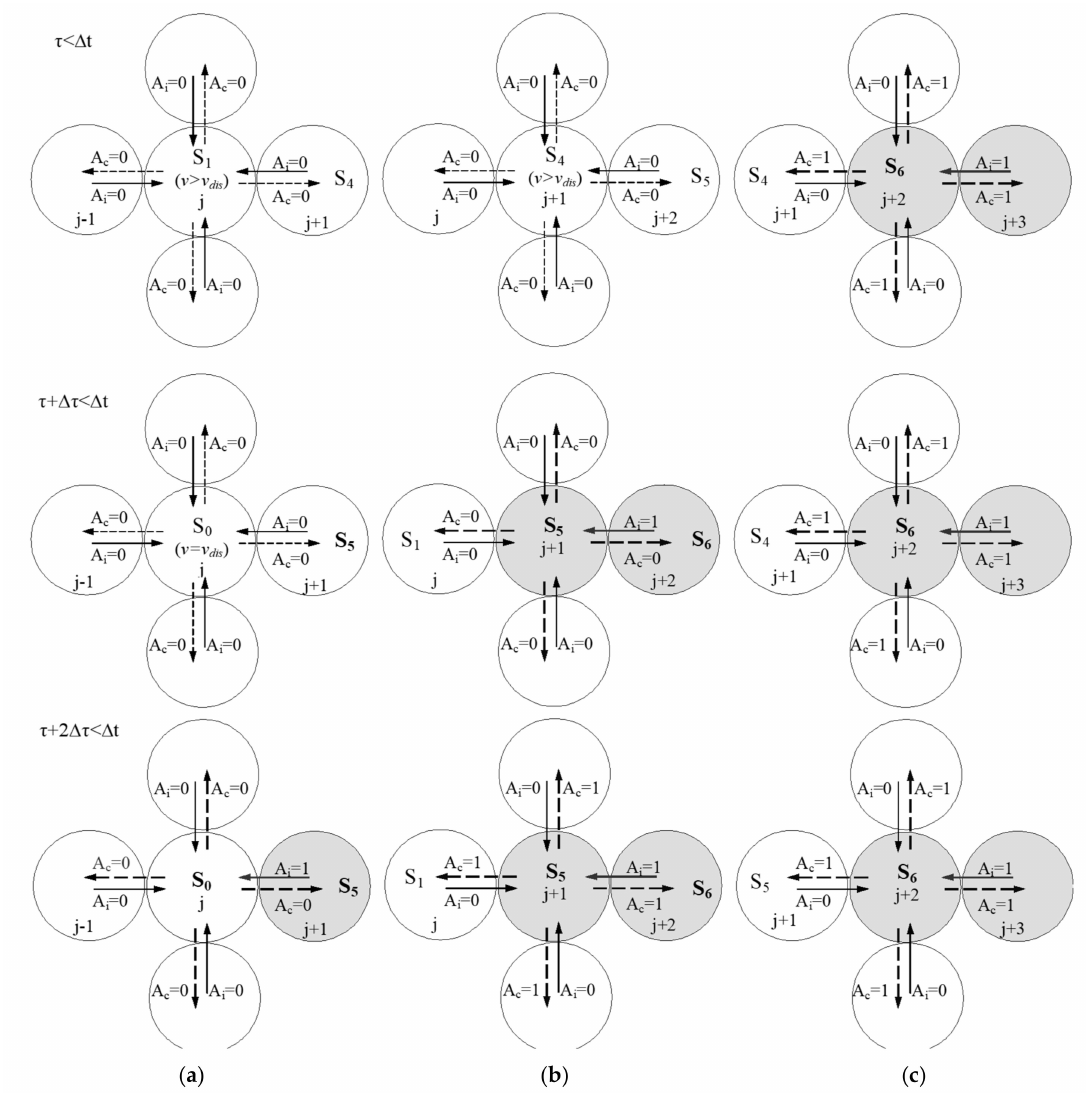
Figure 4. Detail of the dialogue where diffusion of motion detection is shown through “transparent” pixels ( j + 2 and j + 1), while pixel j deserves an “opaque” behavior. Dialogue at ( a ) pixel j , ( b ) pixel j + 1, and ( c ) pixel j + 2,